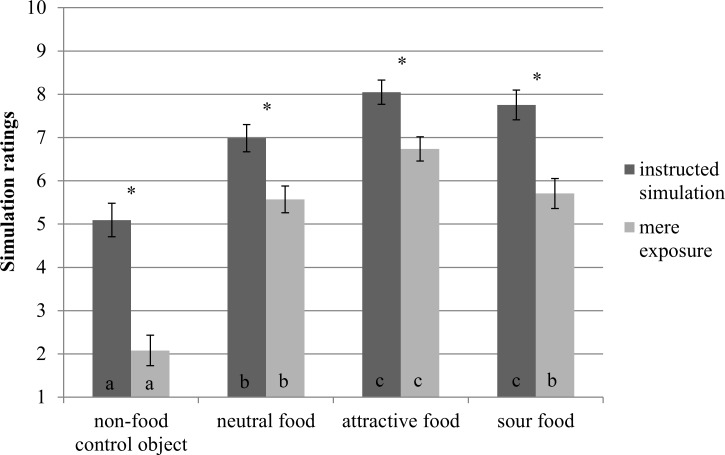
Ratings of consumption simulations by object type and condition in Experiment 2.Different letters indicate significant differences between objects within a condition, p < .05. Asterisks indicate significant differences between conditions for an object, p < .05. Error bars represent standard errors from the mean.